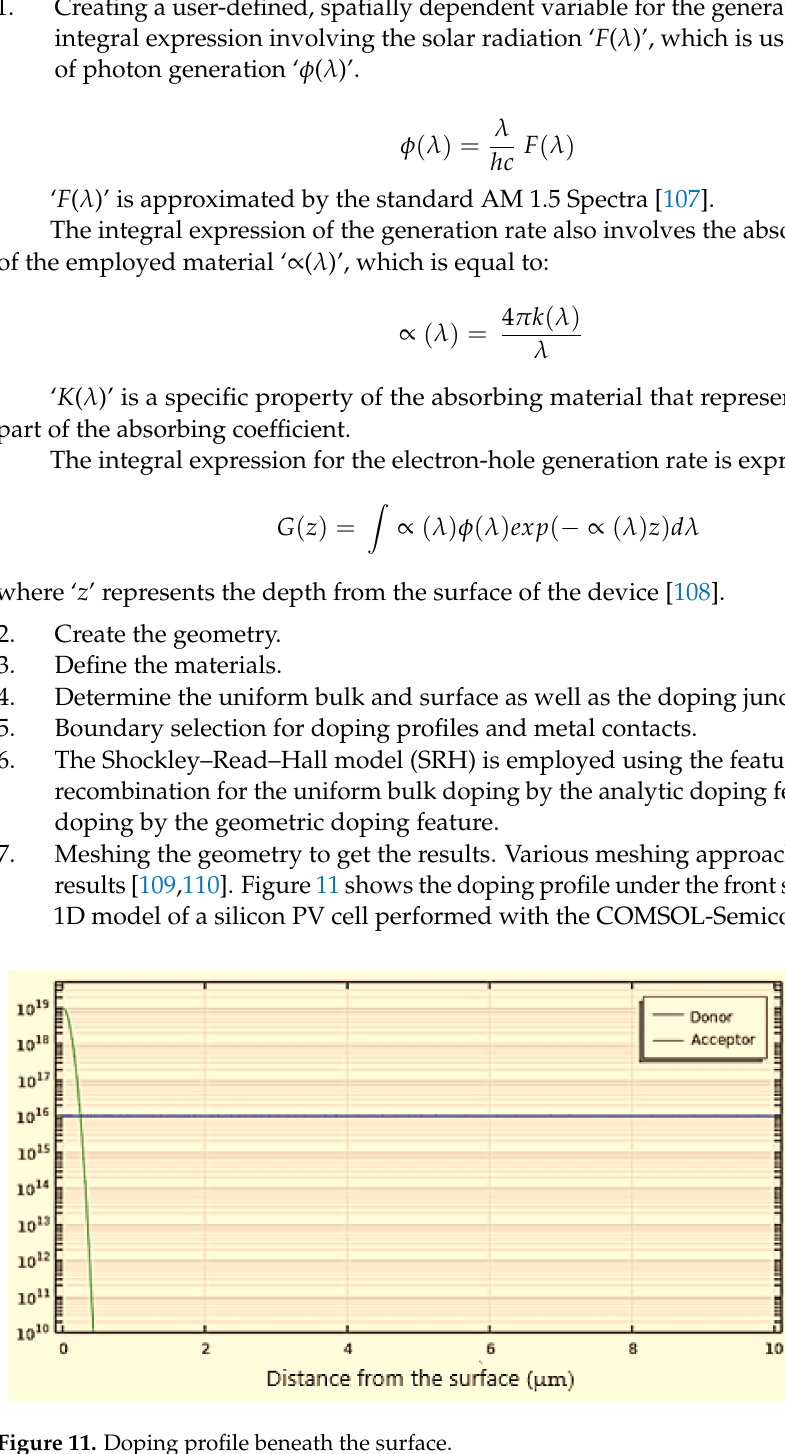
Figure 11. Doping profile beneath the